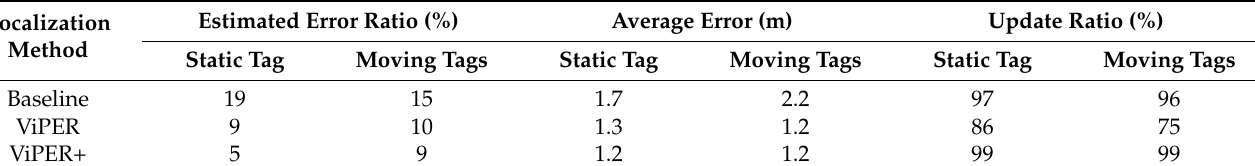
Table 5. The results of worker tracking for LOS scenario without blocking object.